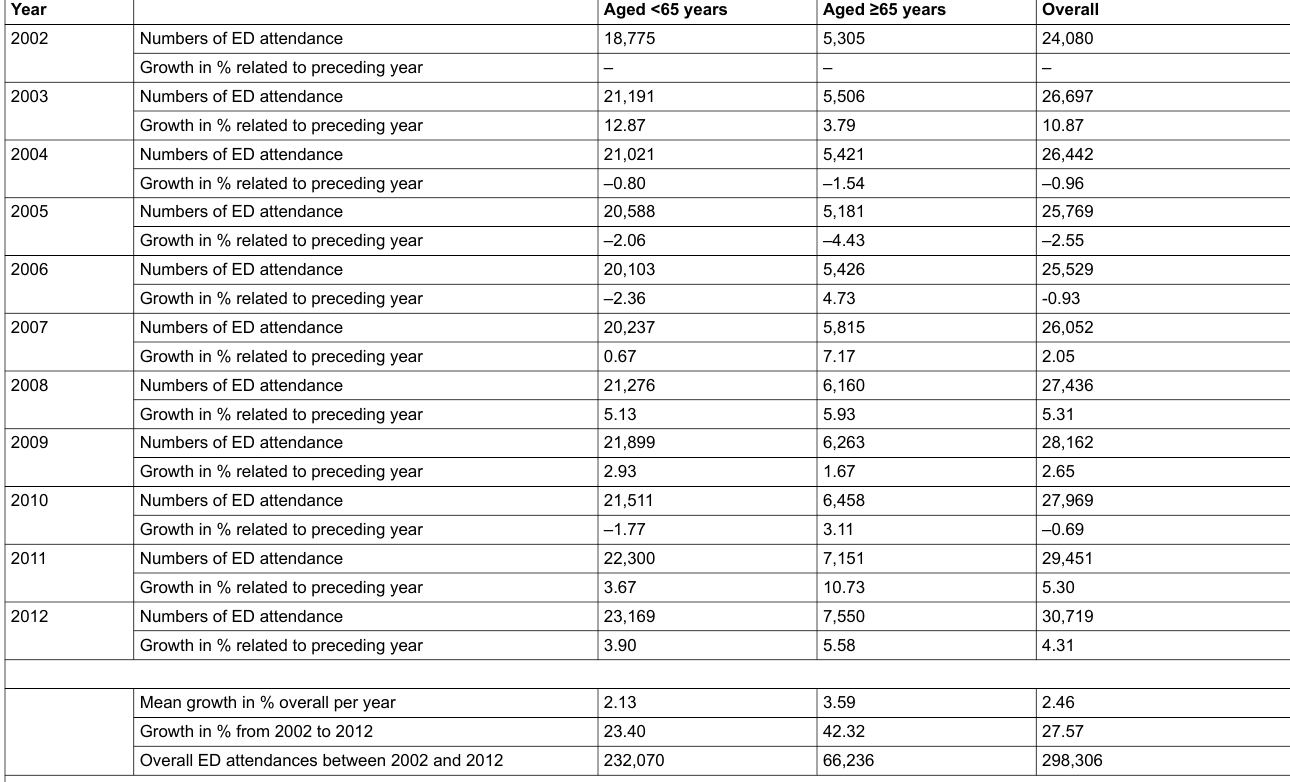
Table 1: Emergency department (ED) attendance of patients <65 and patients ≥65 years between 2002 and